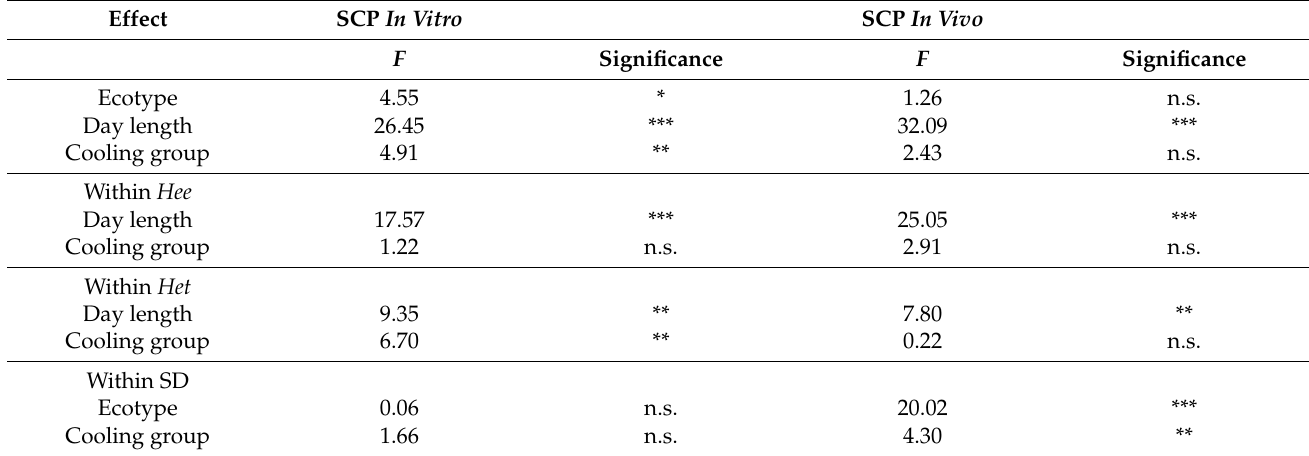
Table 3. Results of the GLM models showing the significances of the effects of the different H. euphorbiae ecotypes, the day length, and the cooling regime on the SCP measurements. *— p < 0.05, **— p < 0.01, ***— p < 0.001, n.s.—not